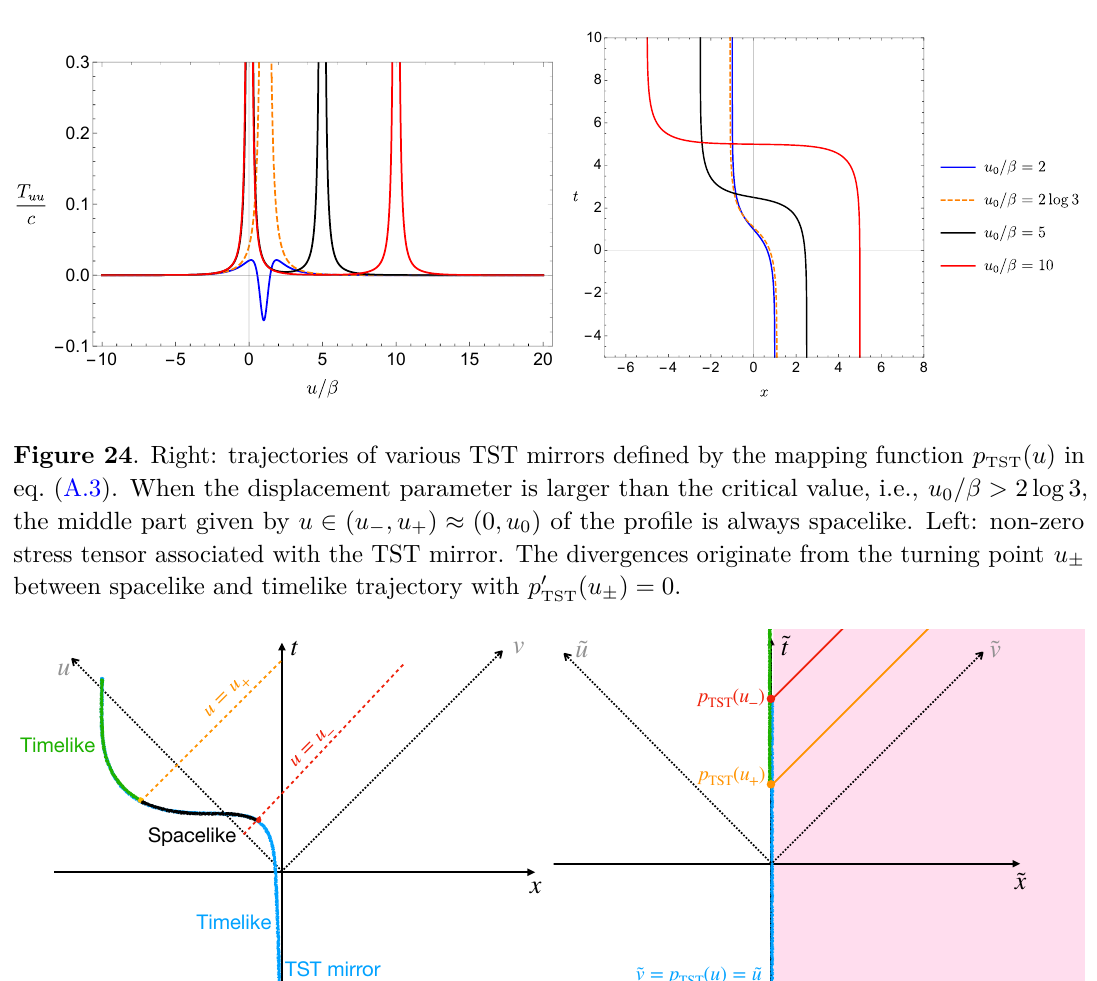
Figure 25 . The map in eq. (A.8) defines the transformation between the TST mirror in the original coordinates, ( t, x ) , and the static mirror in (˜ t, ˜ x ) coordinates. The two timelike parts of the TST mirror are mapped to the static one with a doubly covered region for ˜ t ∈ [ p